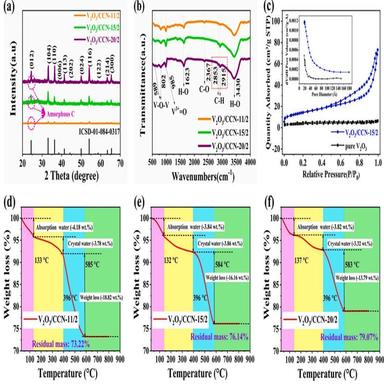
(a) XRD patterns, (b) FT-IR spectrum of the V2O3/CCN composites (c) N2 absorption-desorption isotherms and pore-size distribution of V2O3@CCN-15/2 composites and pure V2O3 and (d-f) TGA curves of V2O3/CCN composites.